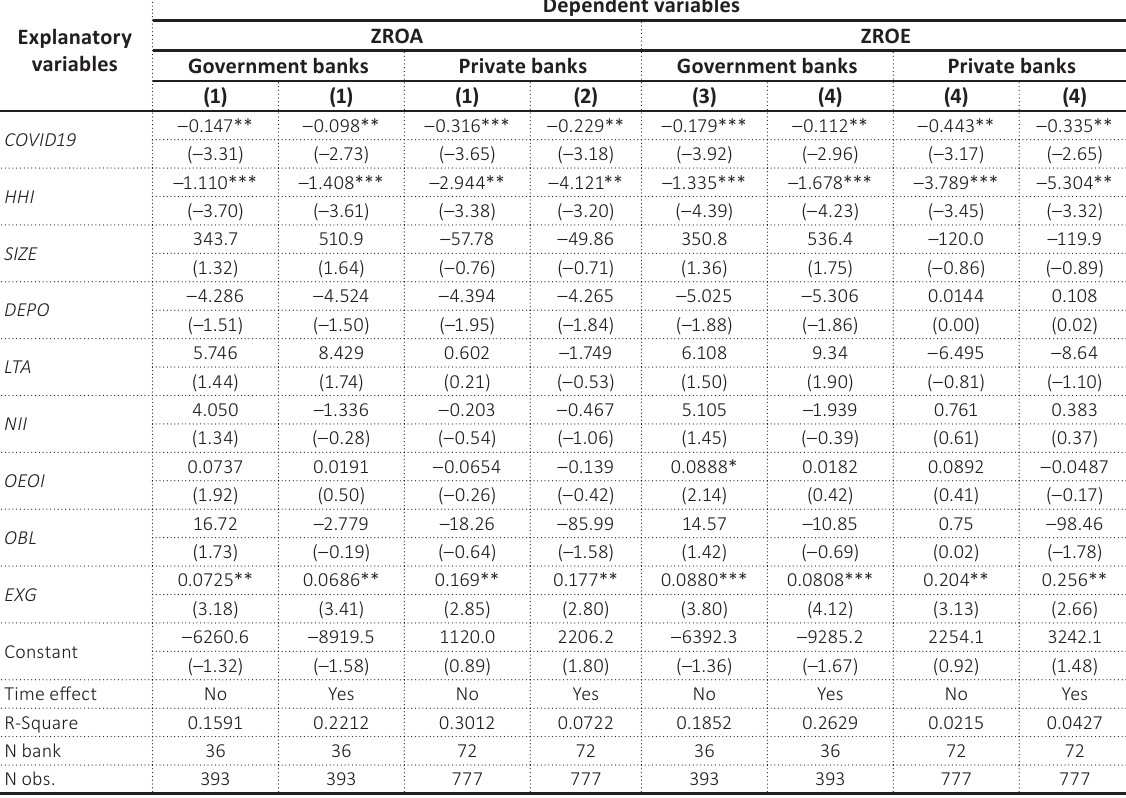
Table 5. COVID-19 and bank stability – government vs private